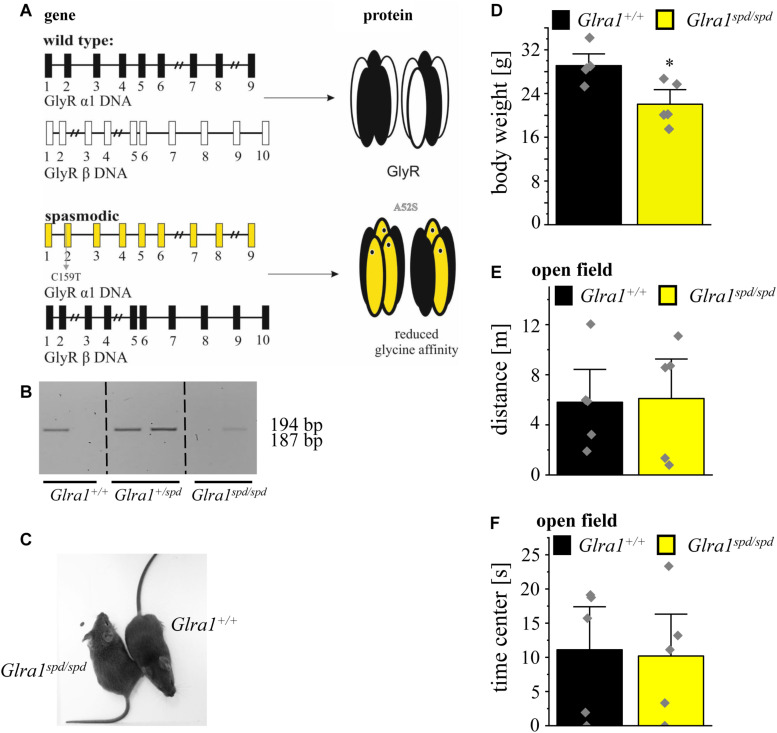
Homozygous spasmodic mice show no anxiety-like behavior. (A) Schematic overview of Glra1 (9 exons) and Glrb (10 exons) genes in spasmodic mice. Upper part shows the wild type situation (black and white), lower part depicts the situation in spasmodic mice (yellow and black). Left column depicts changes at DNA level, note the base pair exchange C159T in exon 2 of Glra1 (yellow) which leads to a missense mutation A52S at the protein level. Right column: Protein level of GlyR with α1A52S marked by a black dot within the GlyR α1 subunit (yellow). (B) Genotyping of Glra1+/+, Glra1+/spd, and Glra1spd/spd mice. Wild type animals show a single 194 bp band, heterozygous animals show two amplimers (194 and 187 bp), homozygous spasmodic mice display a band at 187 bp. (C) Images of Glra1+/+ and Glra1spd/spd animals are shown. (D) Body weight of Glra1spd/spd mice (n = 5, yellow bar) and Glra1+/+ mice (n = 5, black bar). Level of significance refers to ∗p < 0.05. (E) Traveled distance within an open field arena of Glra1spd/spd mice (n = 5, yellow bar) and Glra1+/+ mice (n = 5, black bar). (F) Time spent in the center of the open field documented for Glra1spd/spd mice (n = 5, yellow bar) and Glra1+/+ mice (n = 5, black bar). Data points are shown as gray color squares.